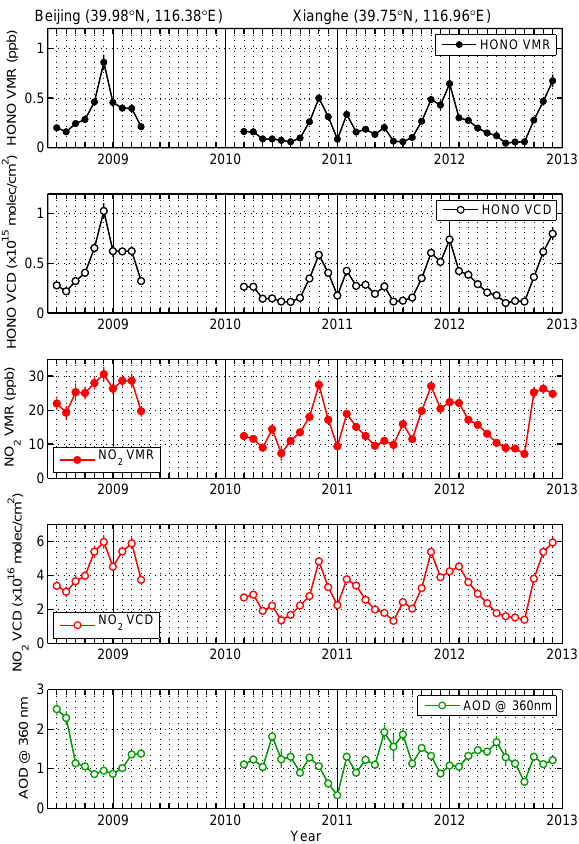
Fig. 7. Time-series of monthly averaged HONO and NO 2 near- surface concentrations (filled circles) and vertical columns (VCD; empty circles) at local noon ( ± 2h) at Beijing (July 2008–April 2009) and Xianghe (March 2010–December 2012). AODs at 360nm retrieved from MAX-DOAS measurements appear in the lower plot. The error bars represent the standard deviation of the